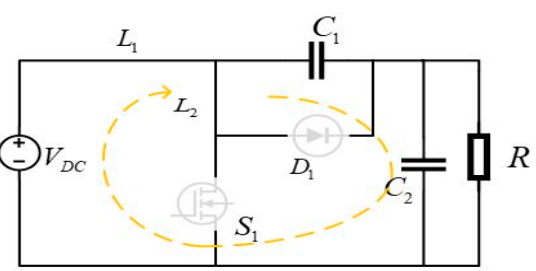
Figure 19. E1 equivalent circuit for computing 𝑽 𝑪